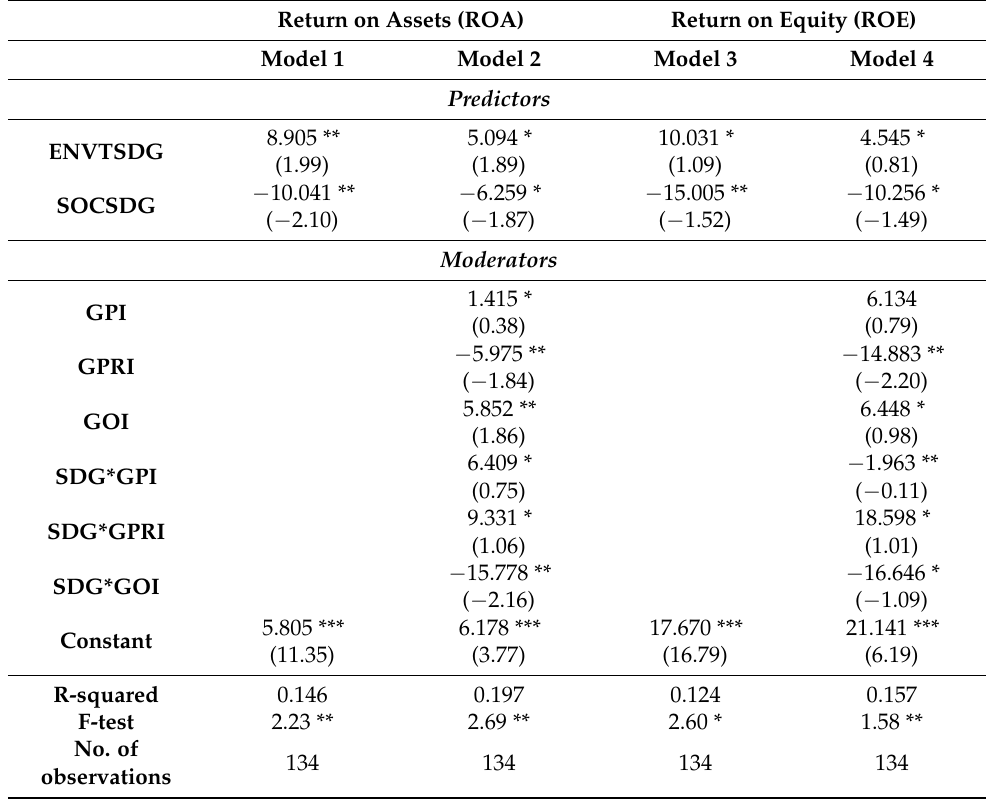
Table 6. Regression